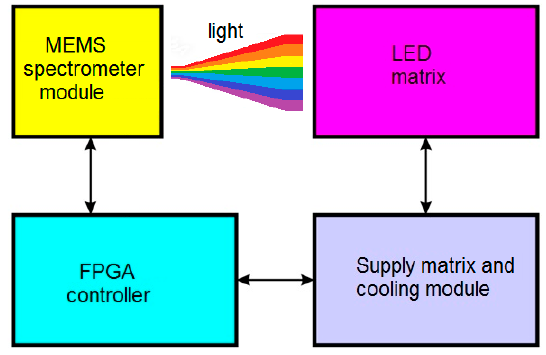
Figure 3. Block diagram of horticulture lamp hardware simulator.